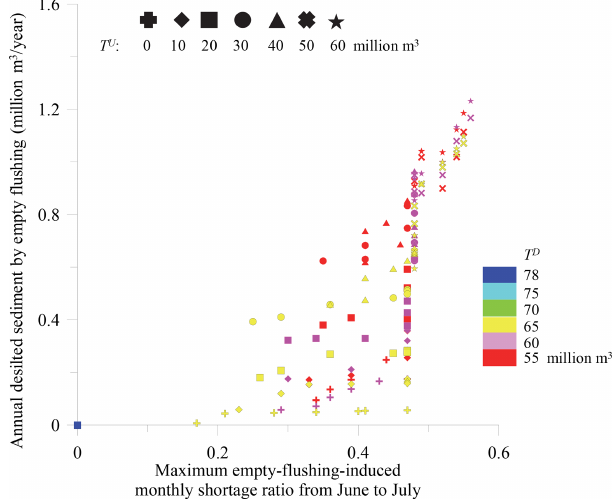
Figure 8. Simulation results of various empty flushing strategies using the original storage balancing curves.